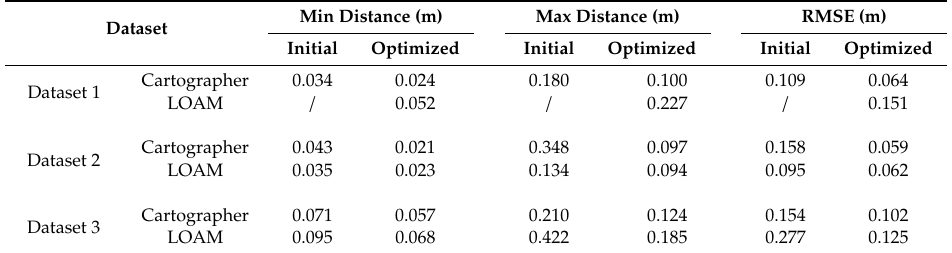
Table 3. The RMSE estimation result of datasets. For the raw output point cloud of LOAM is distorted severely in dataset 1, the initial RMSE values are empty.